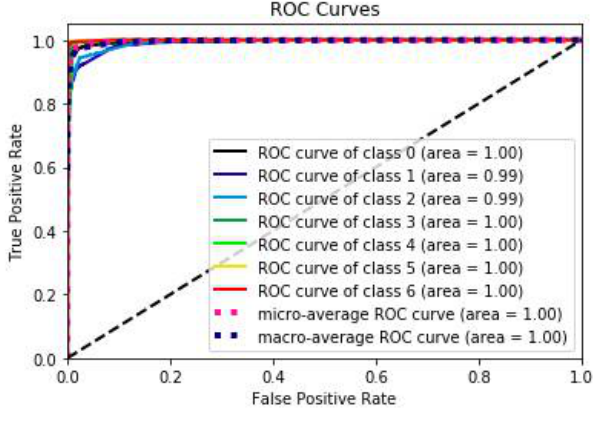
Figure 15. ROC curve.